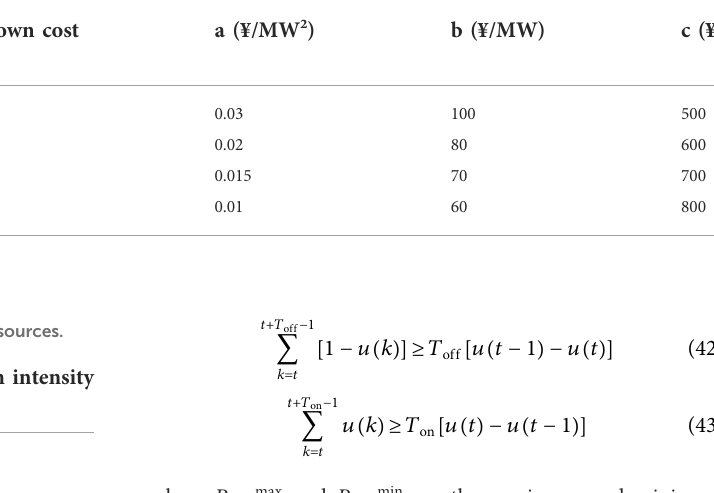
TABLE 2 The cost parameters of power plants.